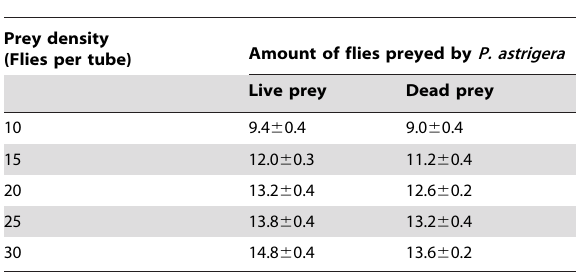
Table 2. The average number ( 6 SE) of live and dead flies preyed upon by Pardosa astrigera at increasing prey densities.